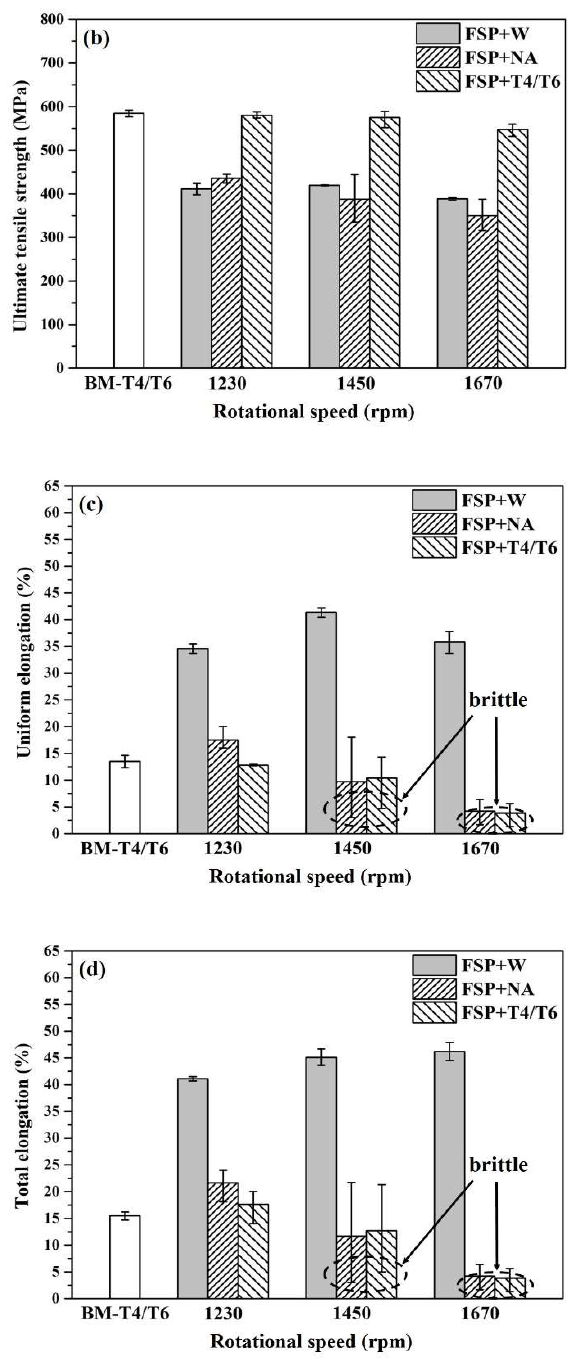
Figure 4. Room-temperature tensile properties of FSP specimens at various tool rotational speeds after PWHTs: ( a ) yield strength (YS); ( b ) ultimate tensile strength (UTS); ( c ) uniform elongation (UE); and ( d ) total elongation (TE). BM-T4/T6 is the raw material used in this FSP experiment.